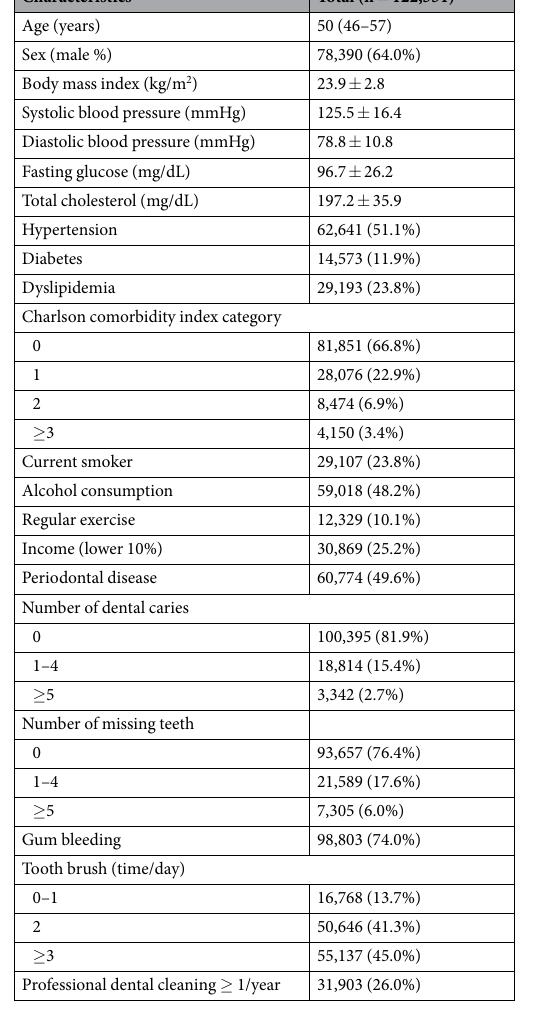
Table 1. Baseline characteristics of study participants (with Def. 3). Data except ages are expressed as mean ± SD or n (%). Ages are expressed as medians with interquartile